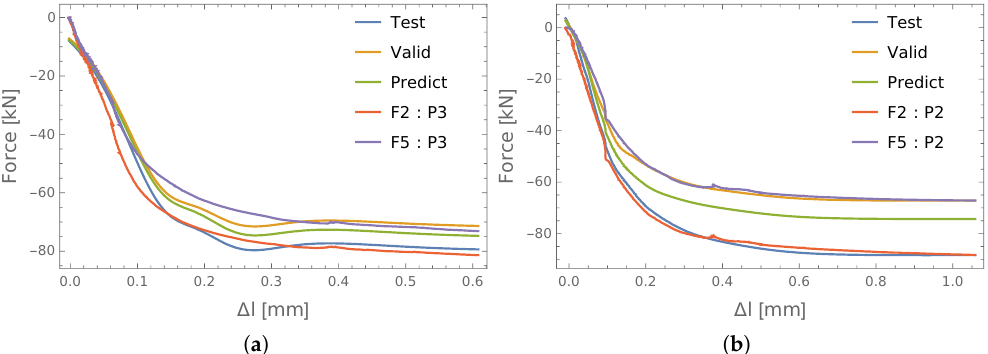
Figure 9. The results of force identification: ( a ) P2 learning, P3 testing; ( b ) P3 learning, P2